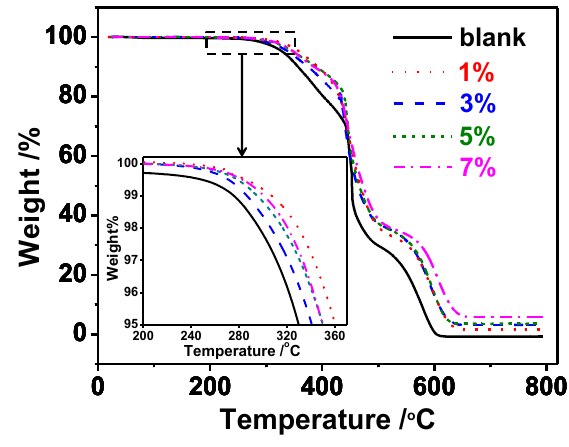
composites (xLCN/SNP) and blank xLCN 2